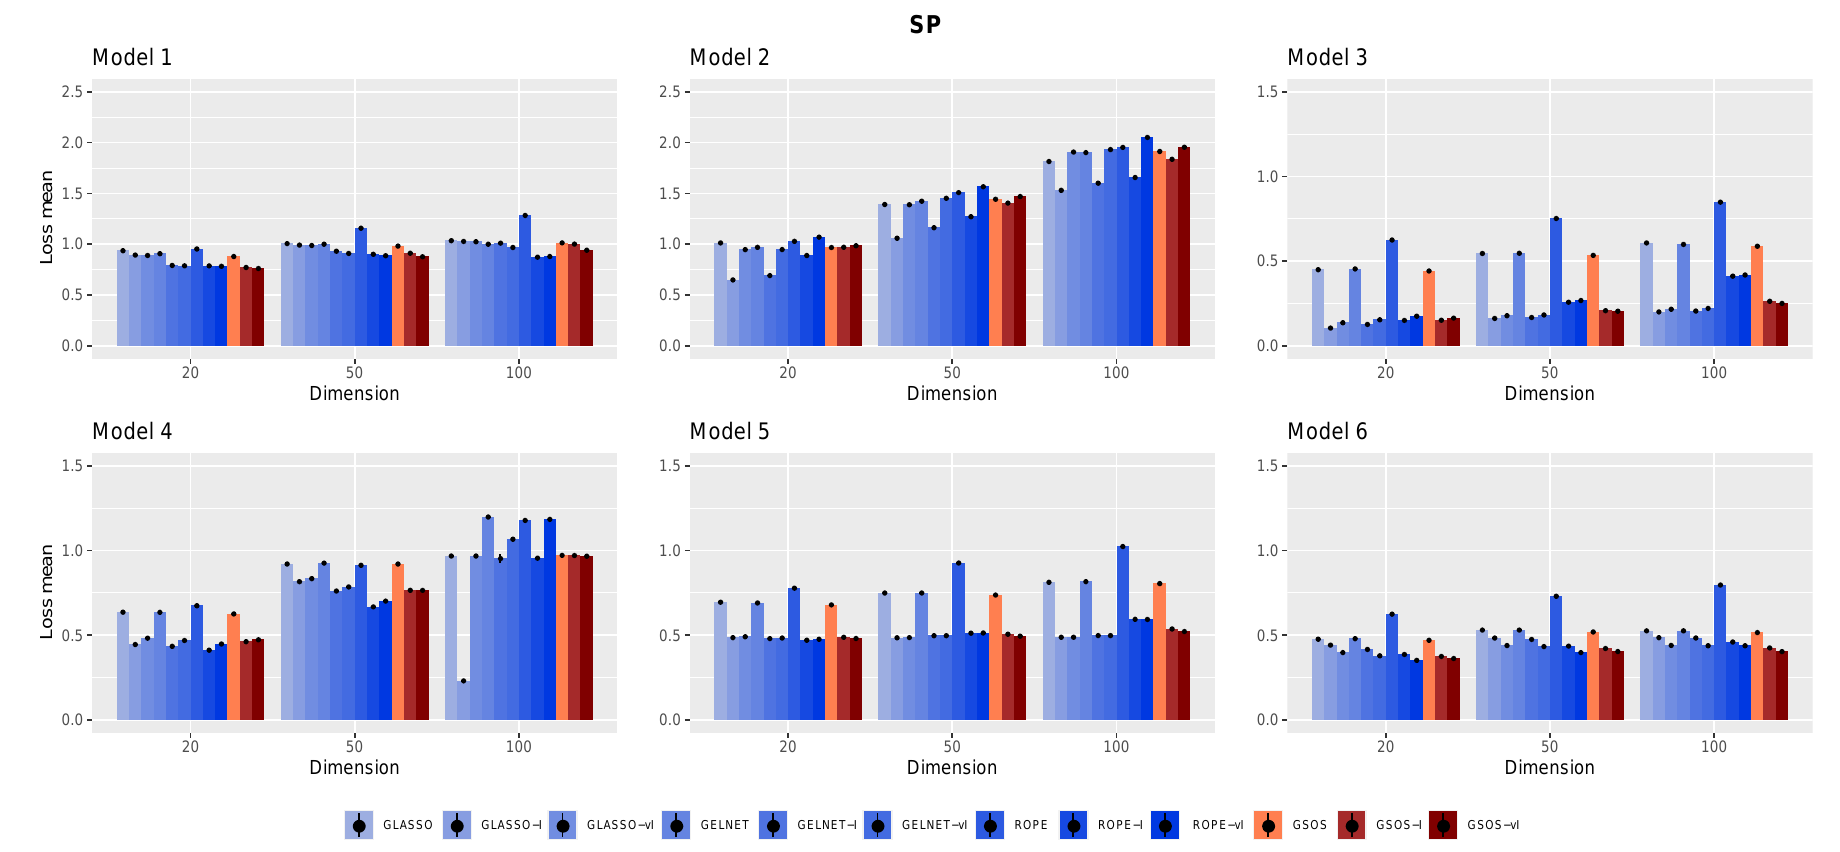
Figure 4. The mean of spectral norm loss for the different models and methods based on 100